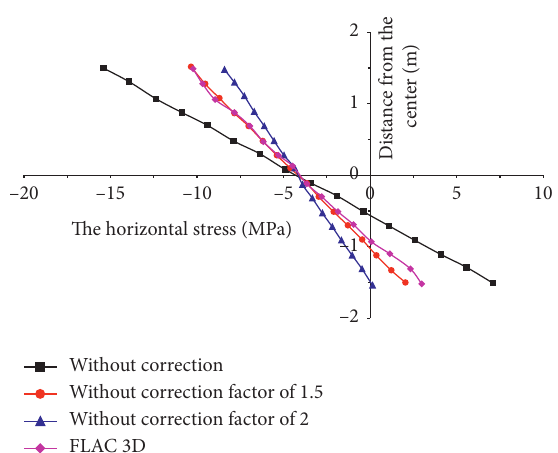
Figure 7: The corrected horizontal stress distribution at the center of thin immediate roof under uniform load.